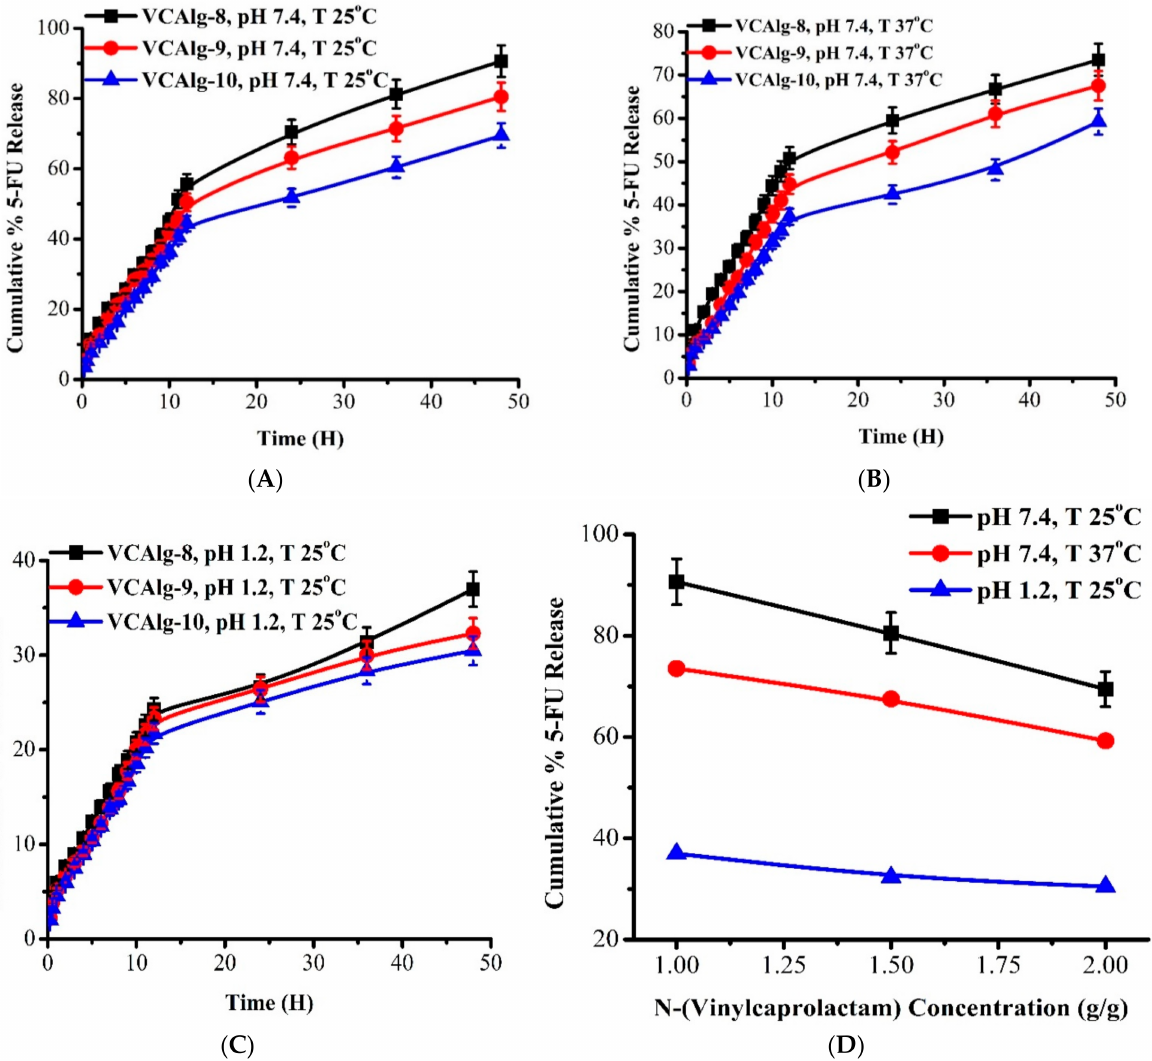
Figure 12. Effect of NVCL contents on cumulative 5-FU release from Poly (NVCL-g-NaAlg) in situ depot gels with time in pH 7.4 (PBS, 5 mM) at 25 ◦ C ( A ), pH 7.4 (PBS, 5 mM) at 37 ◦ C ( B ), and in acidic buffer solution (pH = 1.2) ( C ). Cumulative 5-FU release in buffer solutions of variable pH values at different temperature programs with variable NVCL contents ( D ). The data indicate the mean ± SD of (n =